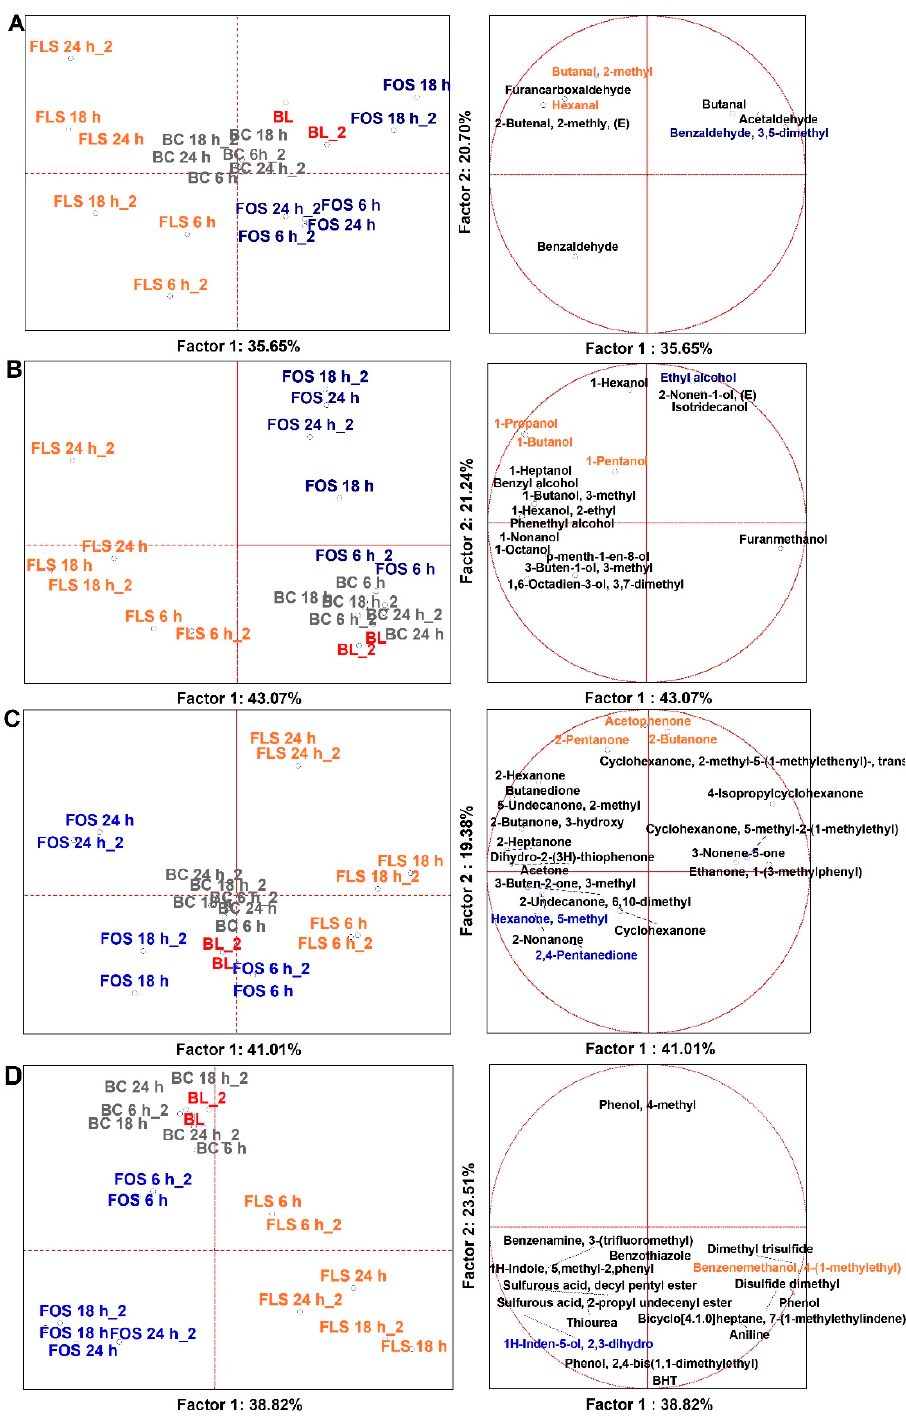
Figure 4. Changes PCAs of the volatilome sorted by chemical classes of significant (ANOVA p < 0.05) VOCs, including 7 duplicated cases ( n = 14), as FOS and FLS fermentations at three different time points (6 h, 18 h, and 24 h) and the baseline (BL). ( A ) = Aldehydes; ( B ) = Alcohols; ( C ) = Ketones; ( D ) = Others (phenolics, sulphurates, amines). FOS = Fructooligosac- charides; FLS = tested fiber; BC = Blank control. Values were recorded over and after 24 h of in vitro batch human colonic fermentations with 1% ( w / v ) FOS and FLS. Samples were analyzed in duplicate from two independent experiments ( n = 4). Left-side diagrams are for PCAs of cases, while right-side diagrams are for PCAs of variables. In the PCAs of variables, the variables with different font colours are the principal descriptors of FLS (orange) and FOS